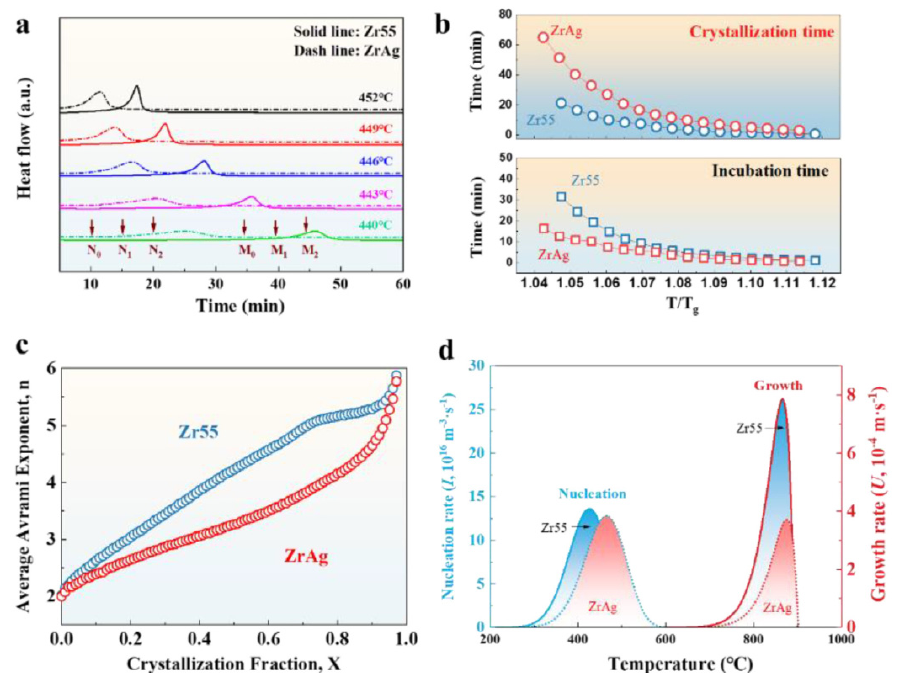
Figure 41. ( a ) Isothermal annealing of ZrAg and Zr55 MG ribbons at different temperatures, ( b ) comparison of the crystallization time and incubation time of the two MGs, ( c ) average Avrami exponent for the two MGs at different crystallization fractions, and ( d ) calculated nucleation rates ( I ) and growth rates ( U ) of the two MGs. Reproduced from [72], with permission from Elsevier, 2021. Ouyang et al. [72] showed that the crystal growth rate was the controlling factor, i.e., ZrAg with the lower growth rate led to a higher amorphous content (see Figure